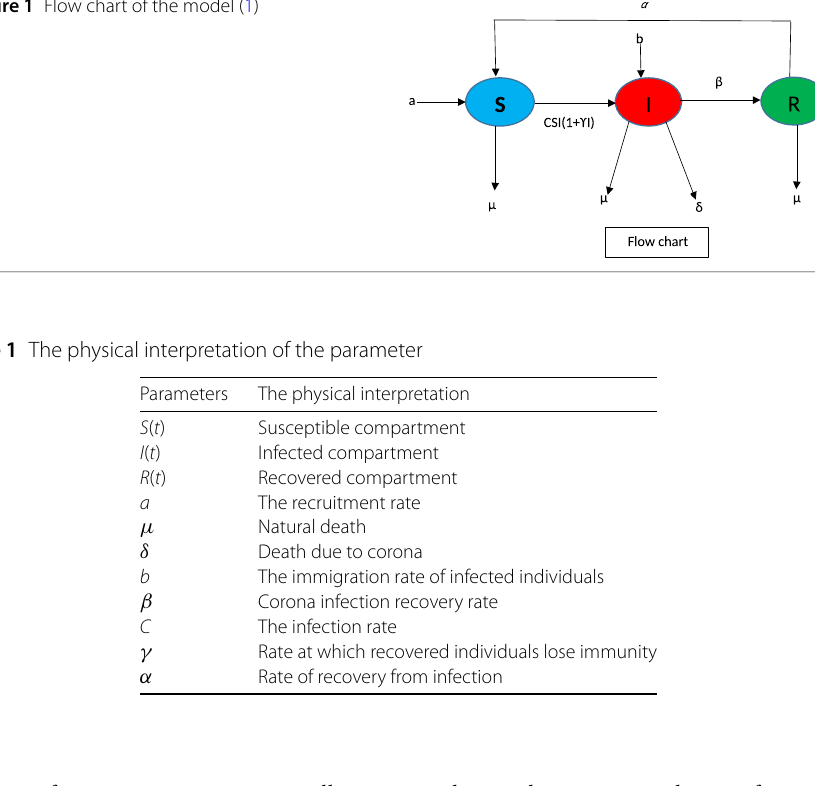
Figure 1 Flow chart of the model (1)